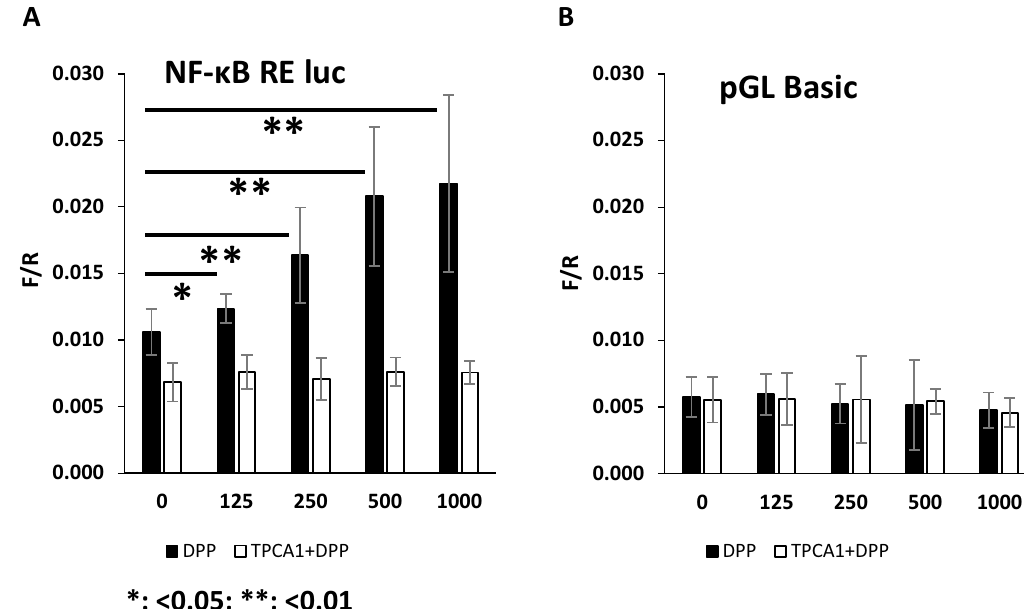
Figure 7. Activation NF-κB promoter with DPP stimulation. The NF-κB RE luciferase reporter ( A ) or the promoter less luciferase activity assay was performed using DPSCs stimulated with DPP in the presence or absence of p65 inhibitor TPCA-1. Luciferase activity of increased with DPP stimulation from 0–500 ng/ml ( A ). Activity was abrogated when cells were treated with TPCA-1 and then stimulated with DPP. Control pGL basic vector showed no activity when stimulated with DPP ( B ). The data are presented as means of ratio of firefly luciferase (F) to renilla luciferase (R), bars show mean ± SD. *p < 0.05, **p <